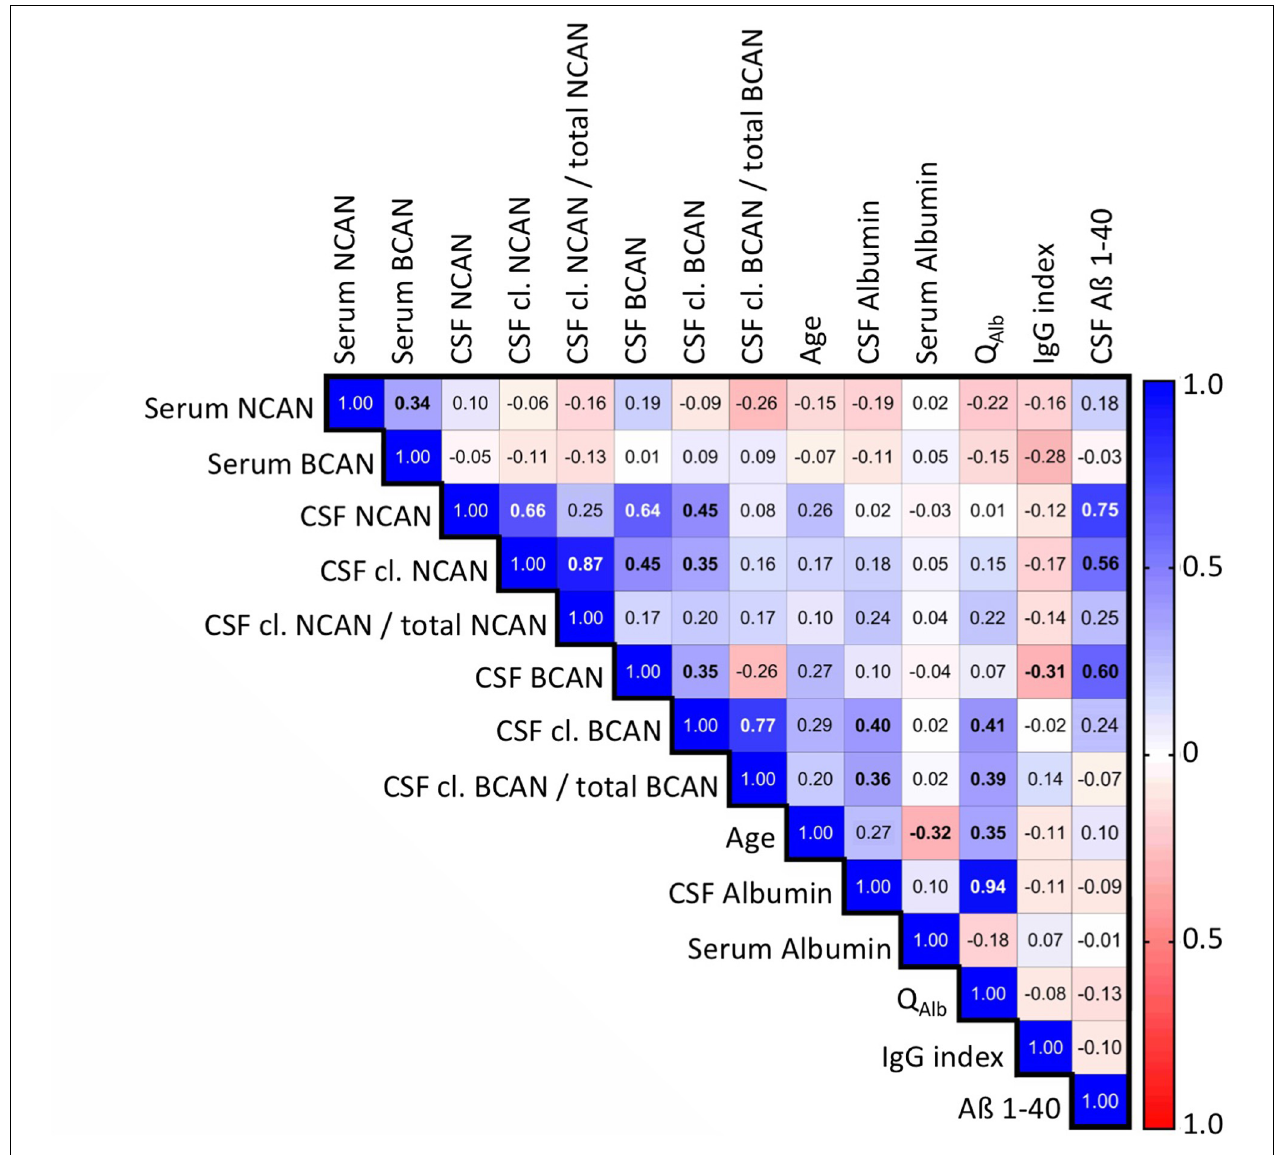
FIGURE 3 | Spearman’s correlation matrix of the concentrations of ECM proteoglycans brevican and neurocan in the CSF and serum of all patients including controls with demographic and serological factors measured during diagnostic work up. Values show the Spearman rank results (significant correlations are indicated in bold). R values are color-coded with blue colors showing positive correlations, red showing negative correlations, and white showing insignificant correlations. BCAN, brevican; NCAN, neurocan; cl., cleaved; Q Alb , albumin quotient; IgG index, Immunoglobulin G index.